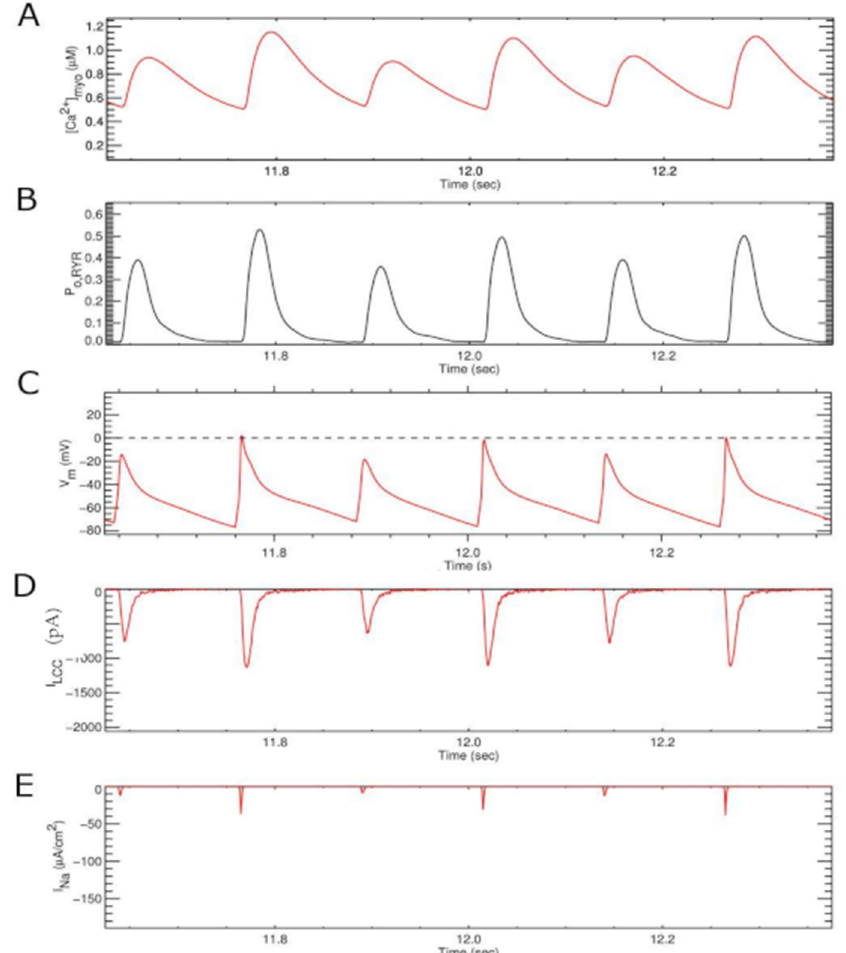
Figure 5. Calcium alternans at 8 Hz: A. Cytosolic calcium, B. RyR open probability Po (RyR2), C. membrane potential Vm, D. L-type Ca 2+ current ICaL, E. Sodium current INa .